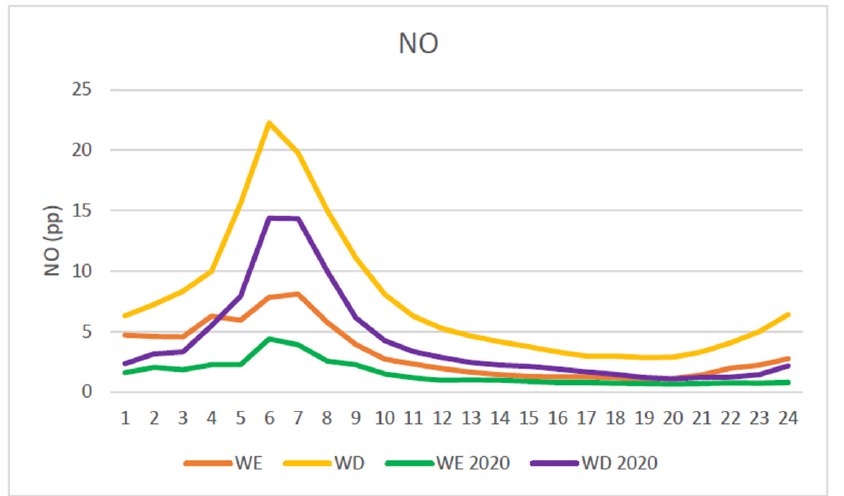
Figure 6. Nitrous oxide (NO) for the average period April to June 2010–2019 for weekends (WE) and weekdays (WD) and for April to June 2020 (WE 2020, WD 2020) at Toronto West.